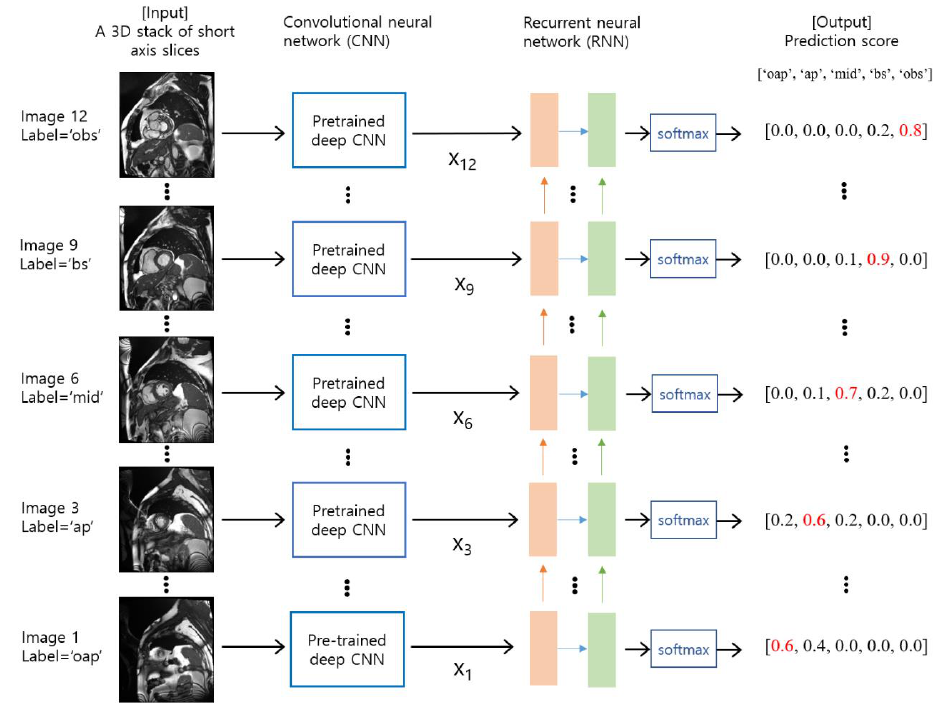
Figure 1. An overview of the proposed method. The input consists of a series of cardiac short axis slice images, which range from the out-of-apical slice level to the out-of-basal slice level. The slice levels were labeled as ‘oap’ for the out-of-apical slice, ‘ap’ for the apical slice, ‘mid’ for the mid-level slice, ‘bs’ for the basal slice, and ‘obs’ for the out-of-basal slice. For each slice image, a pre-trained deep CNN model is used as a feature extractor. The features are denoted by x i for i = 1, 2, …, N, where N is the number of slices. The RNN model takes a series of features (i.e., x 1 , x 2 , …, x N ) as input and produces probability scores for each slice level via softmax. The red numbers indicate the maximum values in the output prediction scores.